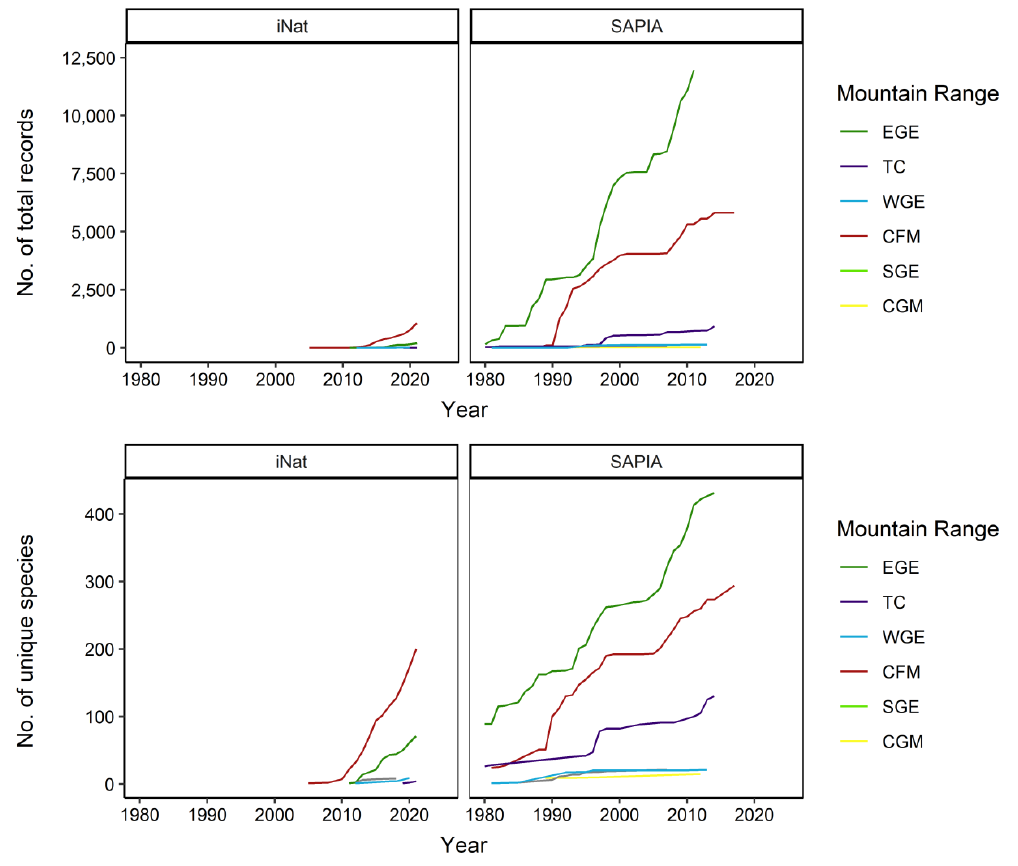
Figure 5. Species accumulation curves showing the number of records over time and the cumulative number of unique species recorded for iNaturalist and SAPIA databases for each mountain range across South Africa.